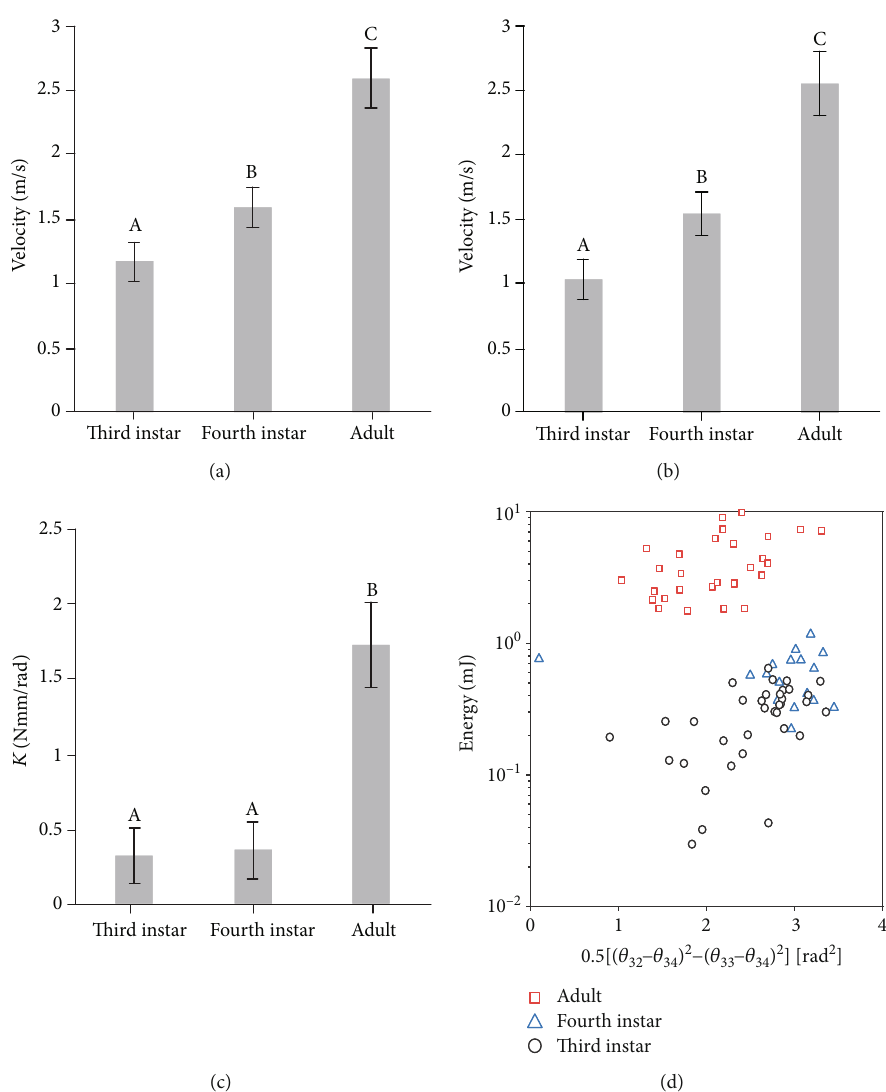
Figure 3: Mean velocities of third instar, fourth instar, and adult L. migratoria at T 3 (a) and T 4 (b). (c) Mean K value calculated based on Equation (2) of all tested third instar, fourth instar, and adult locusts separately. Di ff erent letters above each bar indicate signi fi cant di ff erences ( P < 0 : 05 ). Whiskers represent standard errors. (d) The relationship between the jump energy of locusts after takeo ff phase at